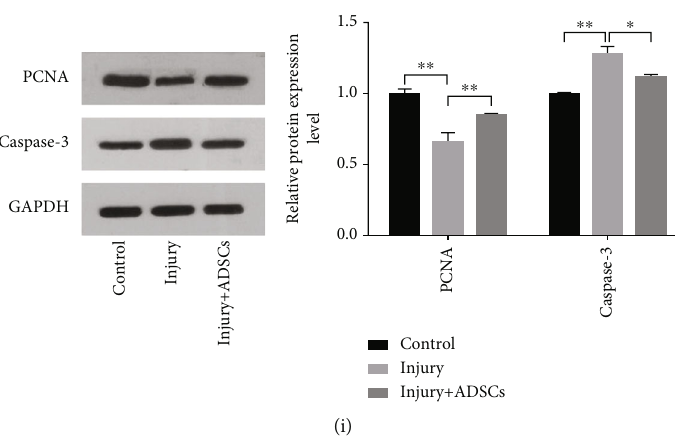
Figure 2: ADSCs rescued the tendon repair through inhibiting oxidative stress and promoting proliferation of tendon cells. (a) HE staining was performed in the control group, injury group, and injury+ADSC group (base magni fi cation: × 200). (b) Immunohistochemistry detected the expression of PCNA and Caspase-3 in tendon tissues (base magni fi cation: × 400). (c – f) ELISA was used to detect the levels of CK, LDH, MDA, and SOD in the control group, injury group, and injury+ADSC group. (g) MTT assay was conducted to detect the activity of tendons cells in the control group, injury group, and injury+ADSC group. (h) FCM was used to detect the apoptosis of cells. (i) The expression of apoptosis-related proteins was detected by Western blot ( ∗ P < 0 : 05 , ∗∗ P < 0 : 01